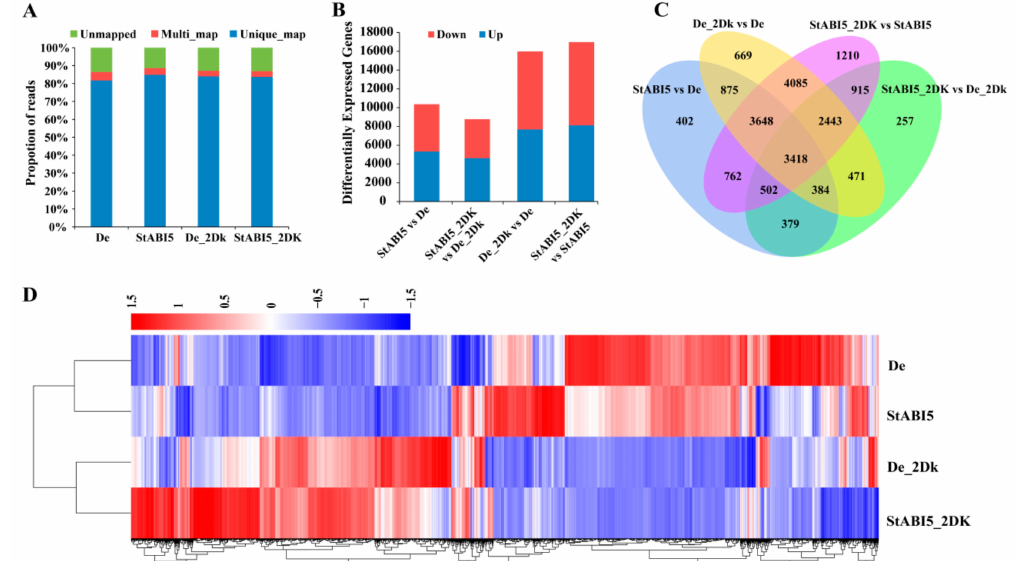
Figure 4. Analysis of di ff erentially expressed genes. ( A ) Proportions of clean reads that were unmapped, mapped to multiple genes, and mapped to unique genes, which were plotted by three replicates of De, StABI5, De_2DK, and StABI5_2DK, respectively. ( B ) Statistical analysis of di ff erentially expressed genes between di ff erent samples. ( C ) Analysis of the overlap of di ff erentially expressed genes between di ff erent comparison combinations by Venn diagram. ( D ) Cluster analysis of di ff erentially expressed genes by heat map. Red represents high gene abundance, blue represents low gene